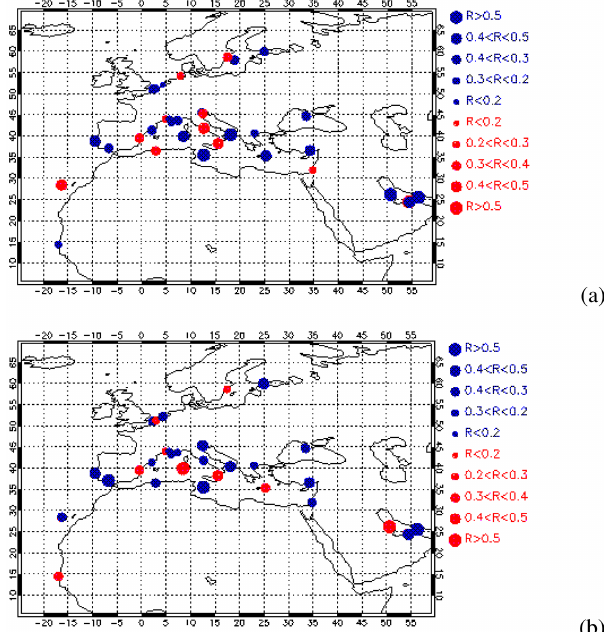
Figure 11. Map distribution of correlation coefficients between (a) MODIS-Terra and AERONET g aer values at 860 and 870nm, respectively (top panel) and (b) MODIS-Aqua and AERONET g aer values at 860 and 870nm (bottom panel). The size of circles corre- sponds to the magnitude of correlation coefficients, while blue and red colors are used for stations for which MODIS and AERONET indicate same and opposite tendency of g aer ,